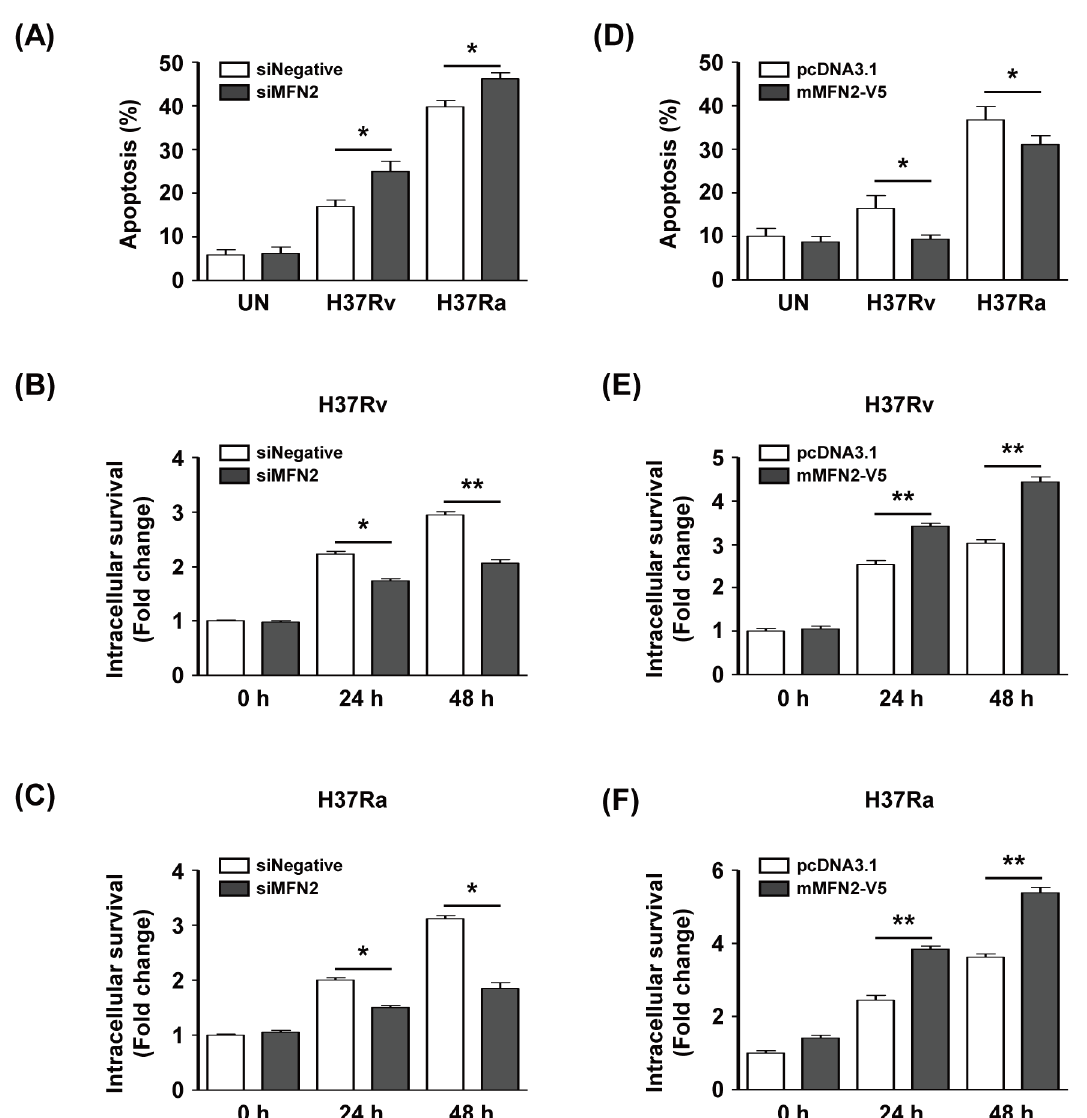
Figure 6. MFN2 regulates intracellular survival of Mtb. BMDMs were transfected with siRNA (siNegative or siMFN2, 200 nM). ( A ) Apoptosis and ( B , C ) intracellular survival of siRNA-treated BMDMs infected with Rv or Ra for 24 and 48 h. ( D ) BMDMs were transfected with pcDNA3.1-MFN2, infected with Mtb (MOI = 1) for 24 and 48 h, and apoptosis was analyzed by flow cytometry. ( E , F ) MFN2-overexpressing cells were infected with Rv or Ra (MOI = 1) for 24 and 48 h, and intracellular survival was assayed by enumerating CFU. Intracellular survival of Mtb was expressed as the change (n-fold) in the bacterial number at a given time point relative to the initial number of invasive bacteria. The sum of Annexin V + / PI − and Annexin V + / PI + cells were considered apoptotic. Data are means ± SD of three independent experiments. * p < 0.05, ** p < 0.01.